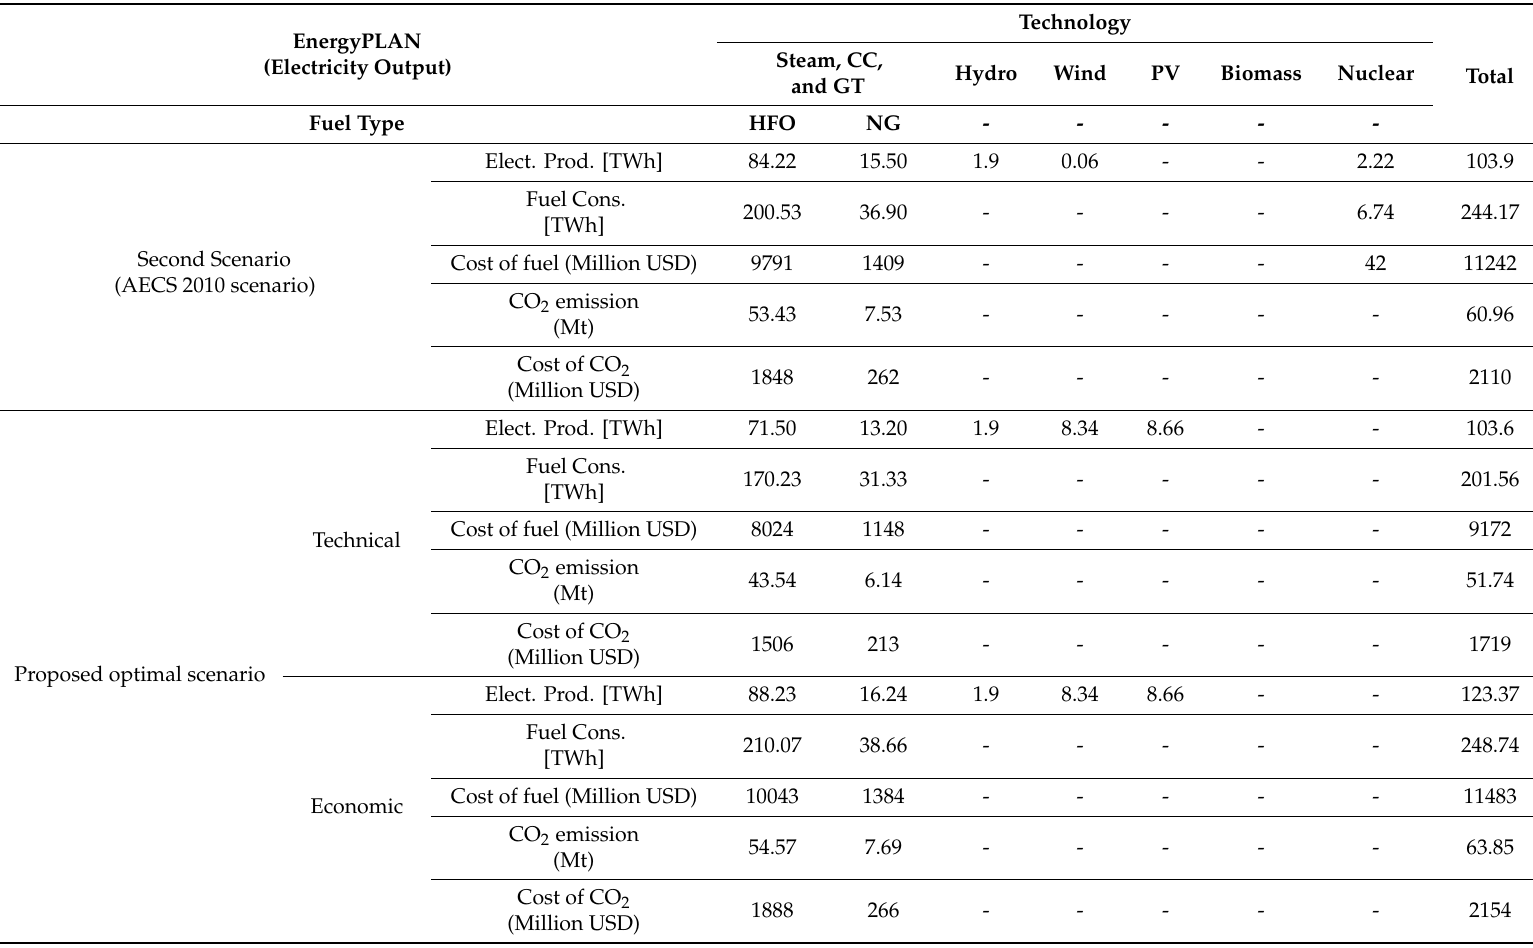
Table 14. Electricity production, fuel consumption, cost of fuel, CO 2 emission, and cost of CO 2 for the AECS and proposed